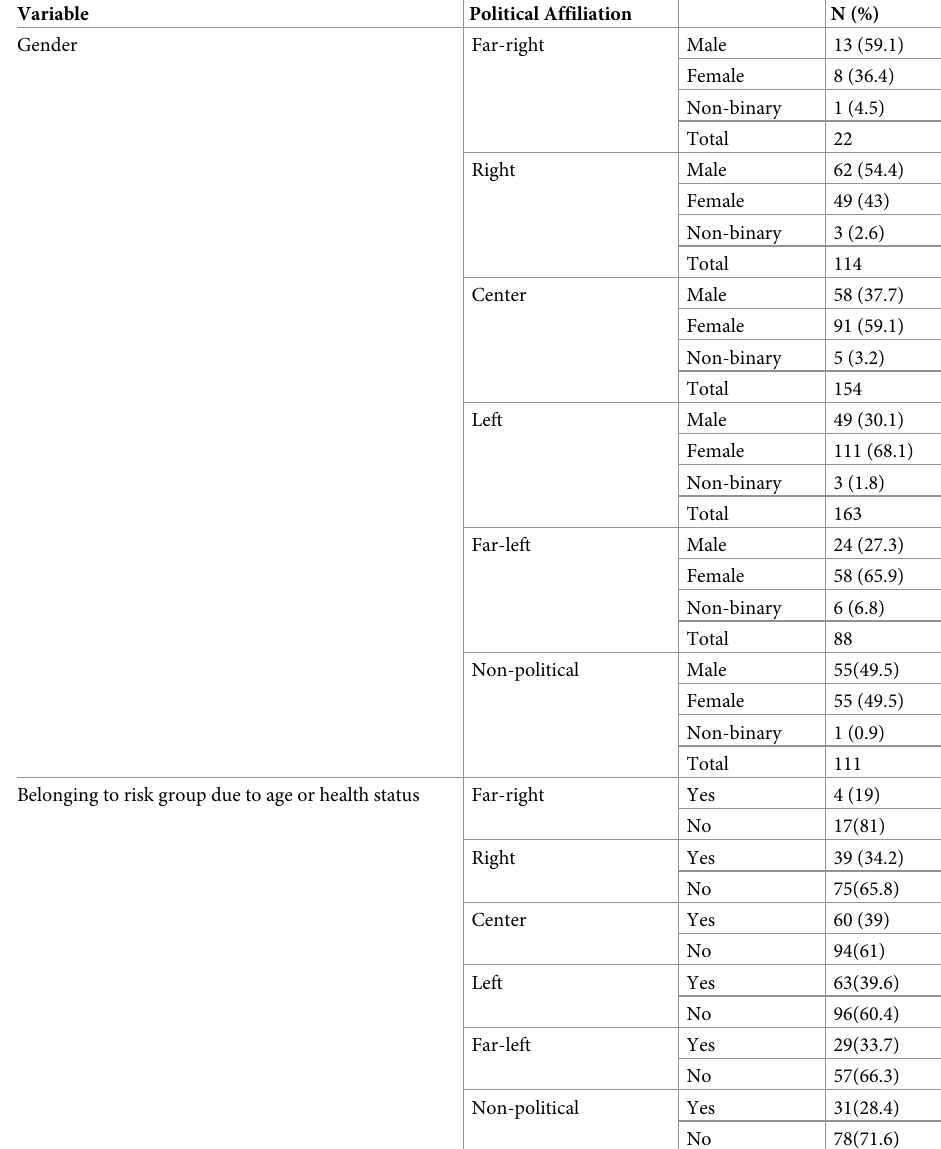
Table 1. Demographic variables: Gender and belonging to a risk